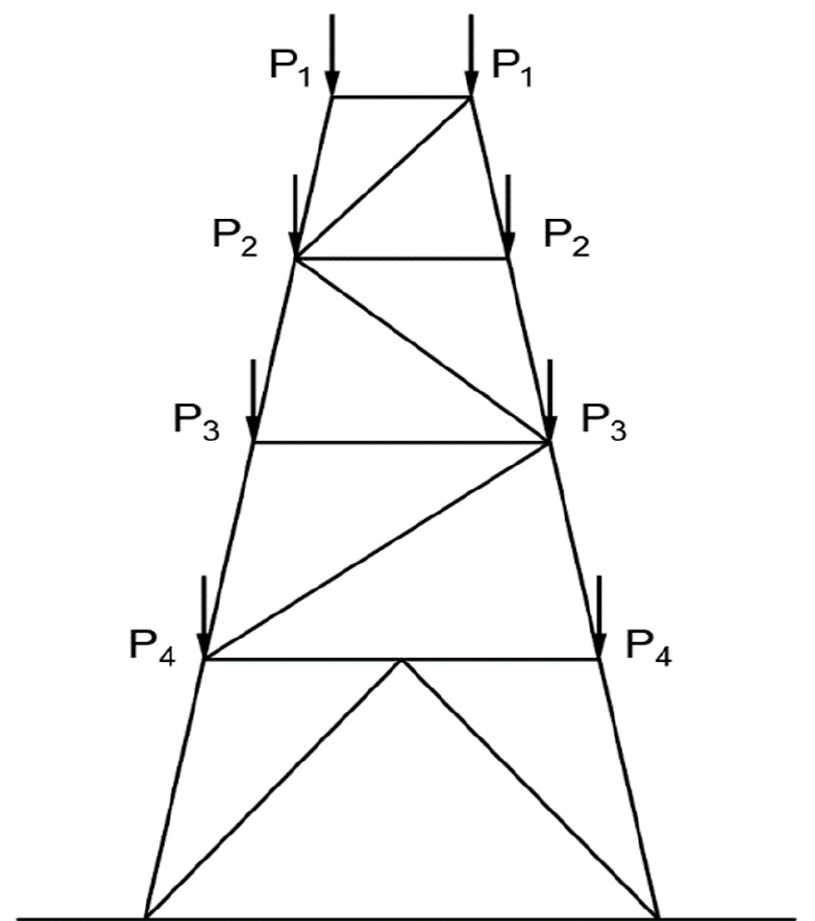
Figure 8. Self-weight load acting mode of the derrick.